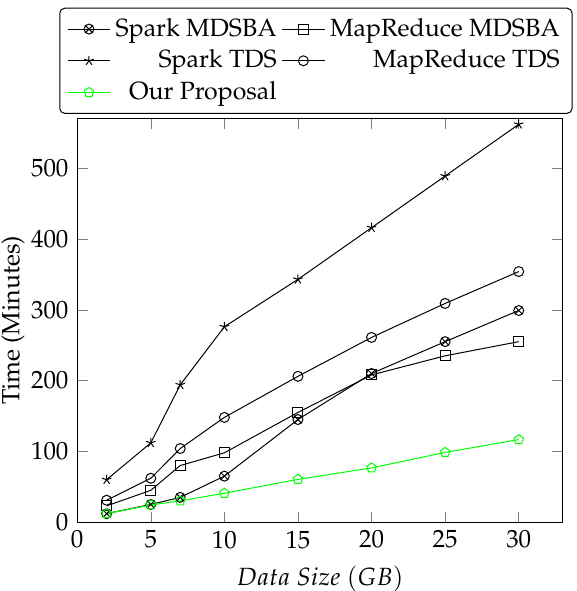
Figure 4. Performance comparison with existing subtree approaches based on increasing data size.